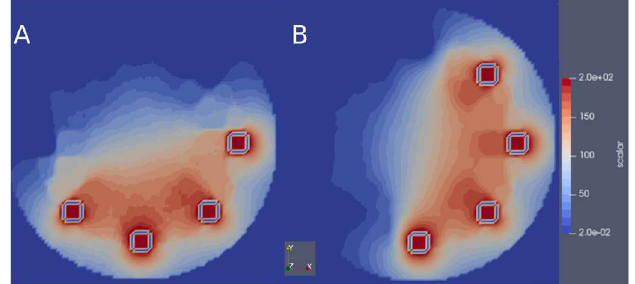
Fig. 16. Electric potential computed with CASICAF’s MC electrostatic solver on a 3D micro pocket detector geometry (Fig. 15). Two cases were studied to consider all the possible configurations. The four anodes at +200 V are delimited by blue squares while cathodes at zero potential are not noticeable. The voxel geometry has a 0.05 mm discretization step. Few million random walks were used to reduce the uncertainty.